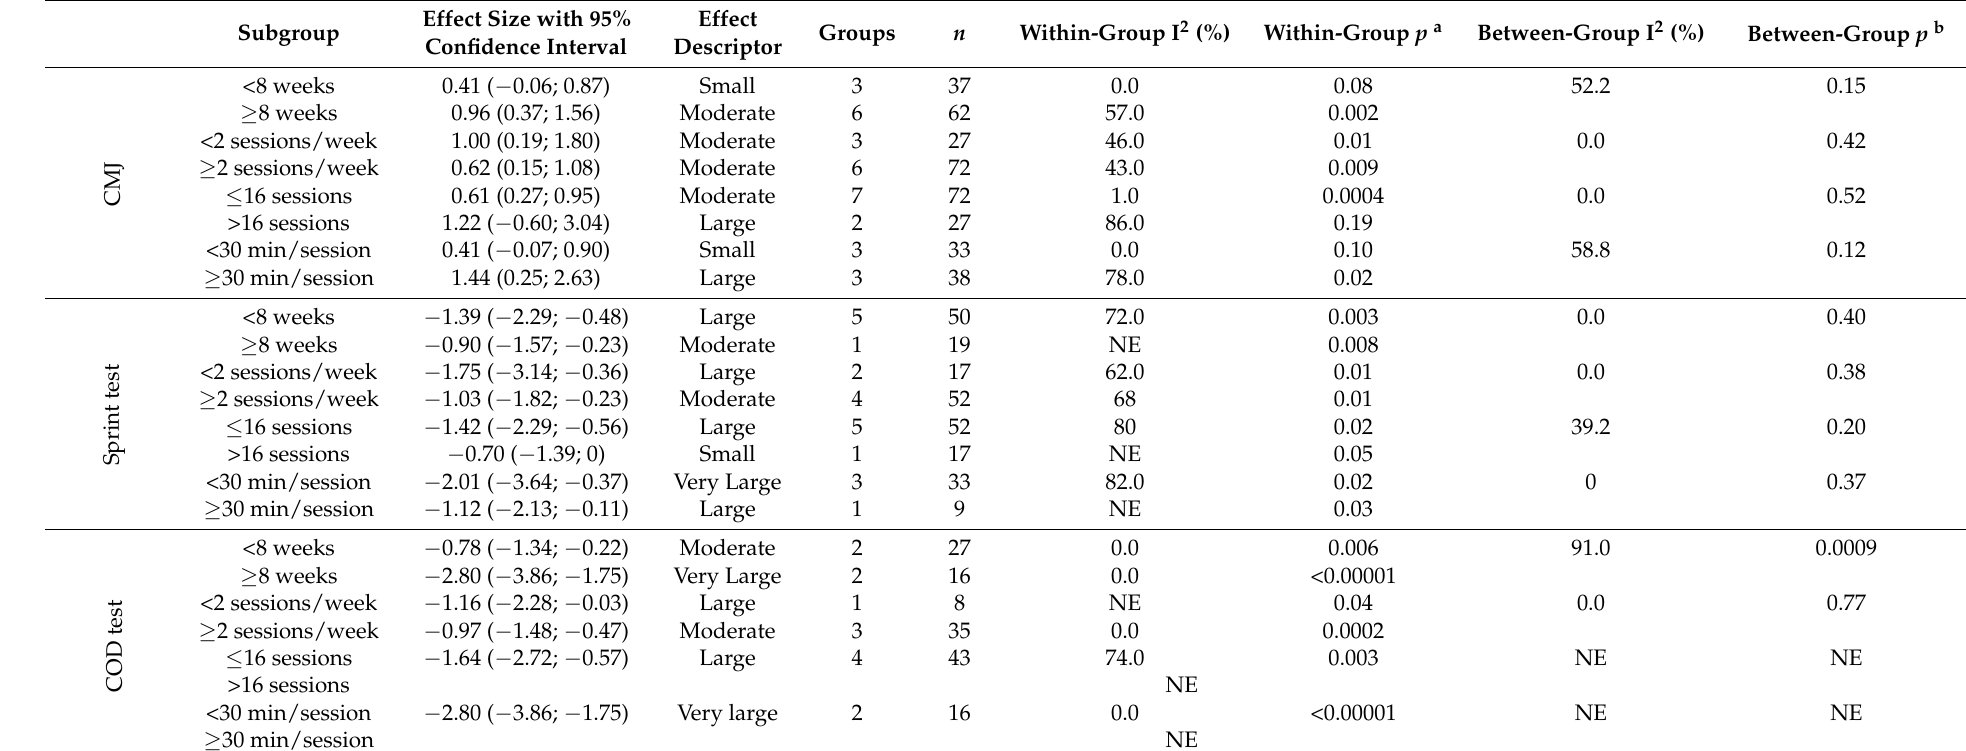
Table 5. Effect of moderator variables with 95% confidence intervals in plyometric